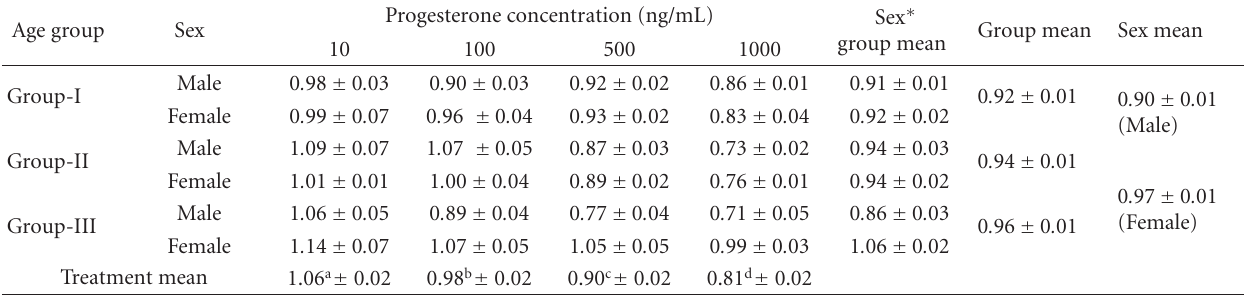
Table 2: Dose dependent e ff ect of progesterone on lymphocyte proliferation in vitro in Murrah bu ff aloes of di ff erent sex and age.